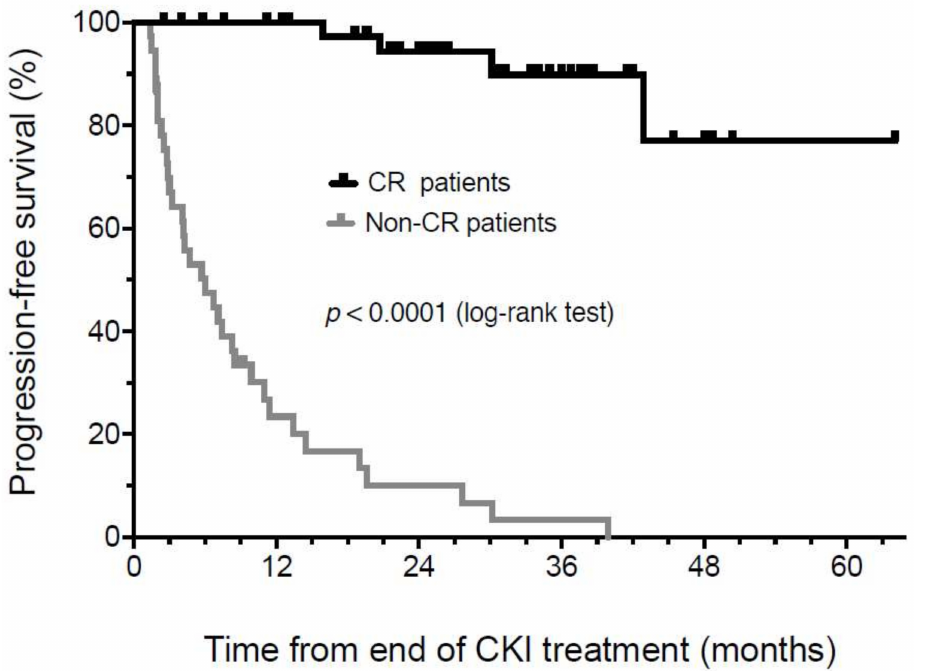
Figure 1. Kaplan-Meier analysis of progression-free survival from the time of treatment discontinua- tion in patients achieving a confirmed radiologic or pathologic CR compared to patients that never achieved complete